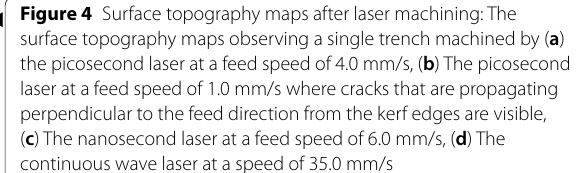
Figure 4 Surface topography maps after laser machining: The surface topography maps observing a single trench machined by ( a ) the picosecond laser at a feed speed of 4.0 mm/s, ( b ) The picosecond laser at a feed speed of 1.0 mm/s where cracks that are propagating perpendicular to the feed direction from the kerf edges are visible, ( c ) The nanosecond laser at a feed speed of 6.0 mm/s, ( d ) The continuous wave laser at a speed of 35.0